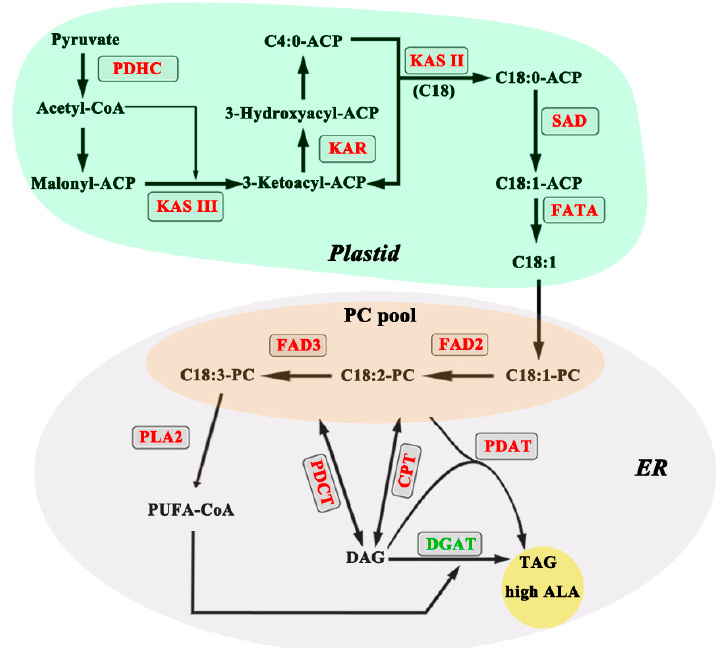
Figure 10. Schematic diagram of high α -linolenic acid (ALA) production. Genes represented in red letters indicate significant difference in expression levels between the two species, with a ratio of P. rockii to P. lutea ≥ 1.5; and genes represented in green letters indicate the P. rockii is significantly lower than P. lutea in expression levels. For abbreviations see Table S4.